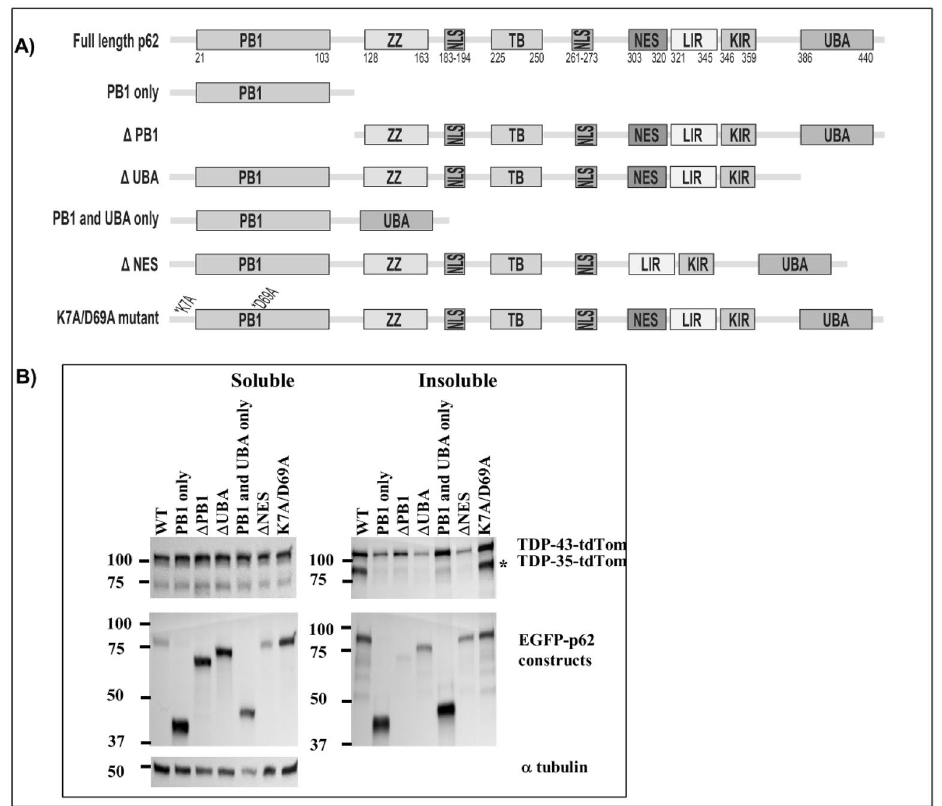
Figure 11. TDP-43 aggregation and cleavage require the PB1 and UBA domains, and the nuclear export signal of p62. NSC-34 cells were transfected with TDP-43-tdTomato and EGFP-p62 wild type [WT] or mutants as indicated. ( A ) Schematic diagram of p62 domain structure and deletion mutants: 1–122 (PB1 domain only), 124–440 (lacks the PB1 domain), 1–385 (lacks the UBA domain), Δ122–386 (PB1 and UBA domains only), Δ303–320 (lacks the nuclear export sequence) and K7A/D69A (self-dimerization mutant). ( B ) Soluble and insoluble fractions were prepared and separated by SDS-PAGE and transferred to nitrocellulose membranes. Western blot analyses were performed as indicated. Image is representative of 3 independent